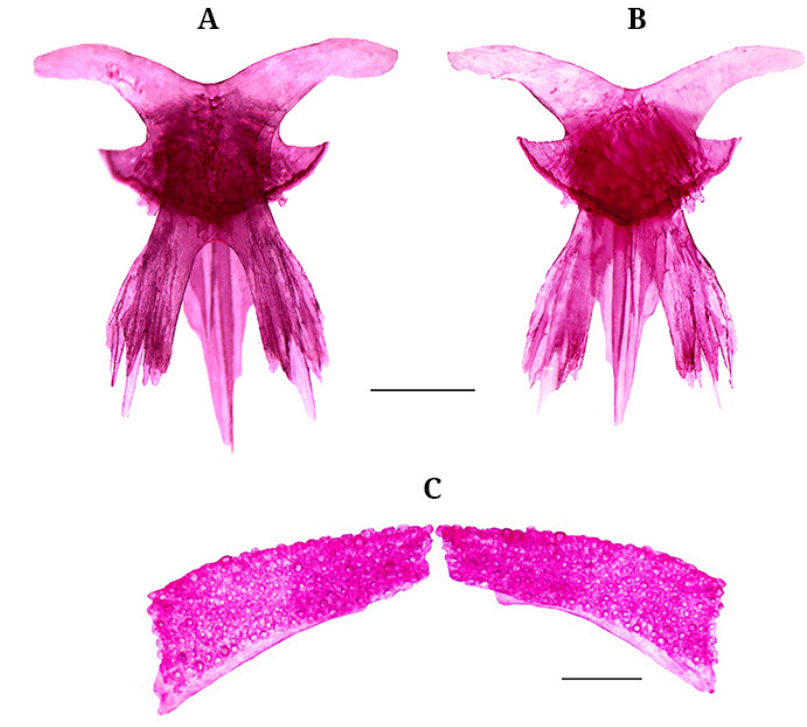
FIGURE 4 | Microglanis berbixae , MECN-DP 3762, paratype, 39.6 mm SL. Mesethmoid-Vomer complex. A. Dorsal view. B. Ventral view. C. Premaxillary tooth plate, ventral view. Scale bars = 1